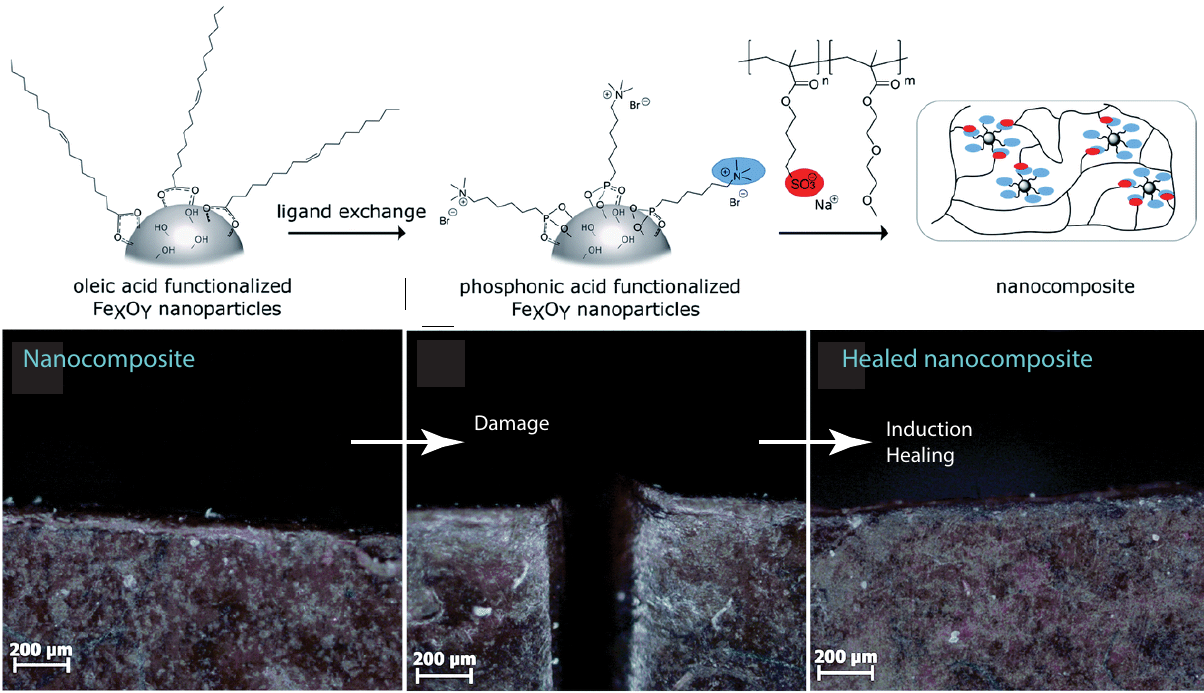
Figure 15. Upper : schematic of the synthesis process of the self-healing nanocomposite. Below : microscope image of the cut and healed nanocomposite samples. Reprinted with permission from Oberhausen and Kickelbick